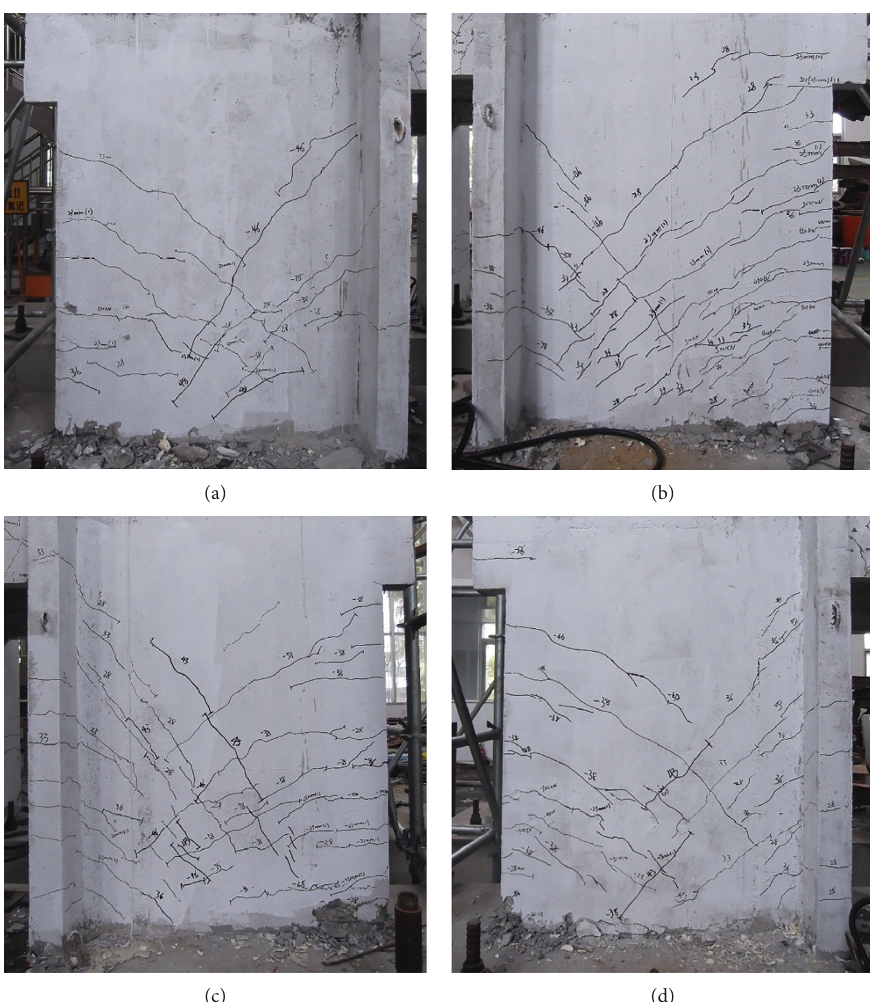
Figure 22: Cracks distribution on precast shear walls. (a) Precast shear wall A. (b) Precast shear wall B. (c) Precast shear wall C. (d) Precast shear wall